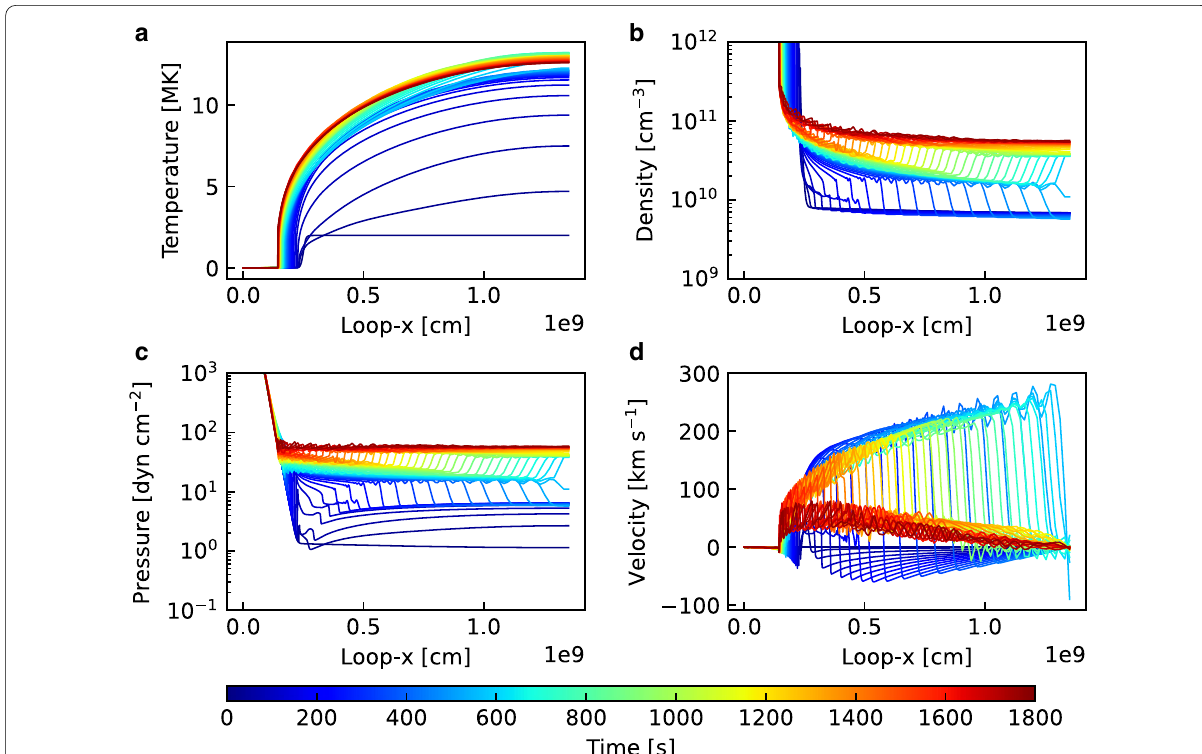
Fig. 6 Calculated results of CANS 1D. The hydrodynamic calculation results with CANS 1D for a temperature distribution, b density, c pressure, and d plasma velocity along the loop. The time evolution is represented by the change in line color from blue to red